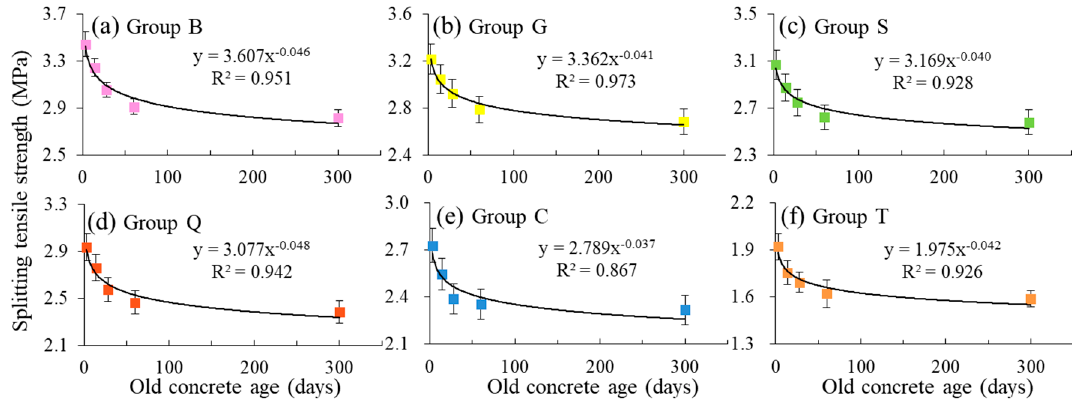
Figure 5. The relationship between splitting tensile strength and old concrete age for new-to-old concrete structure: ( a ) Group B, ( b ) Group G, ( c ) Group S, ( d ) Group Q, ( e ) Group C, ( f ) Group T.